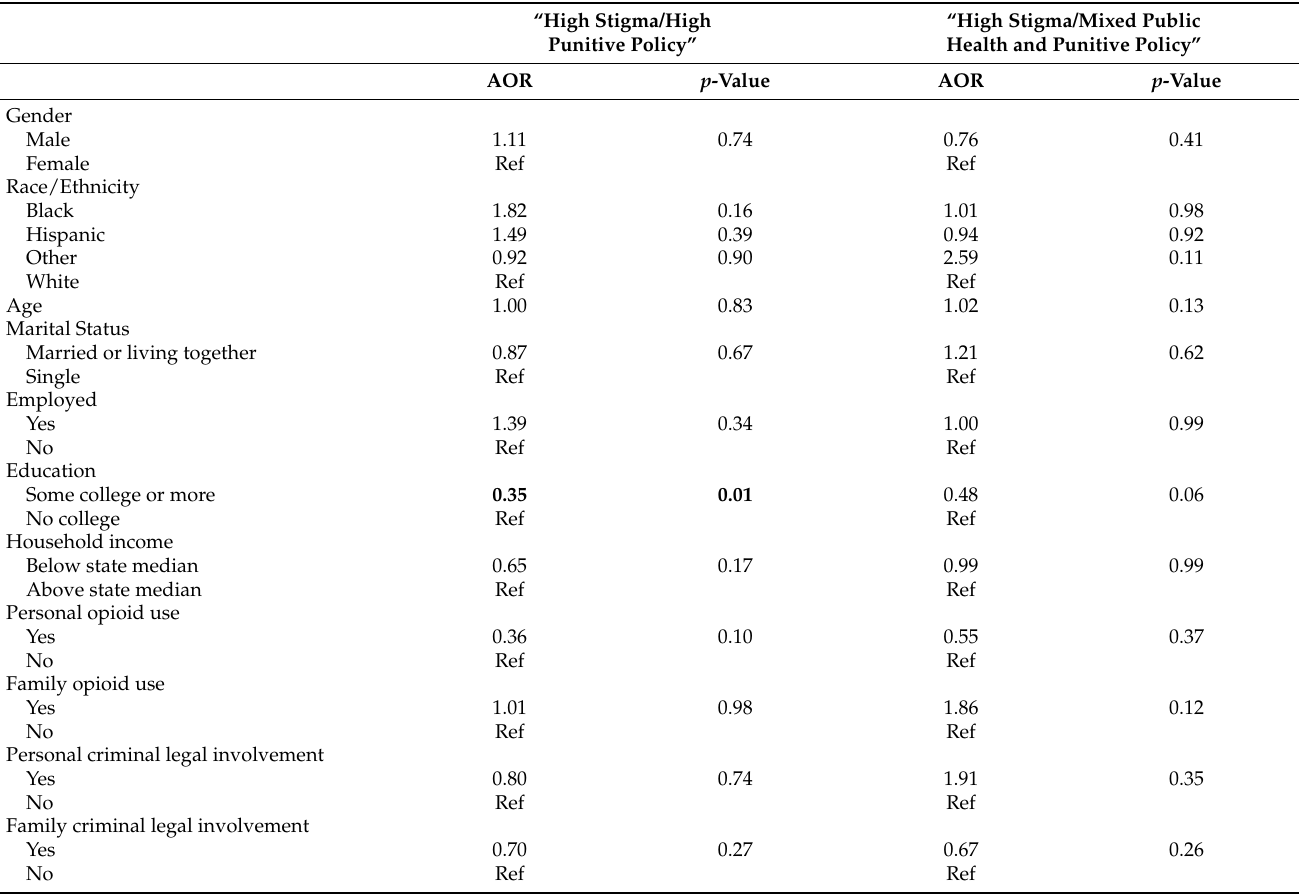
Table 3. Associations between individual characteristics and class membership *. “High Stigma/High Punitive